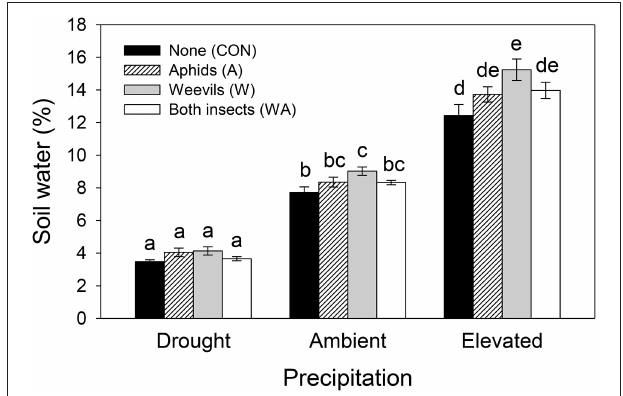
FIGURE 2 | The interactive effects of precipitation and herbivore treatment on soil water content. Mean values ( ± SE) are shown. Bars with the same letters were not significantly different ( P < 0.05).